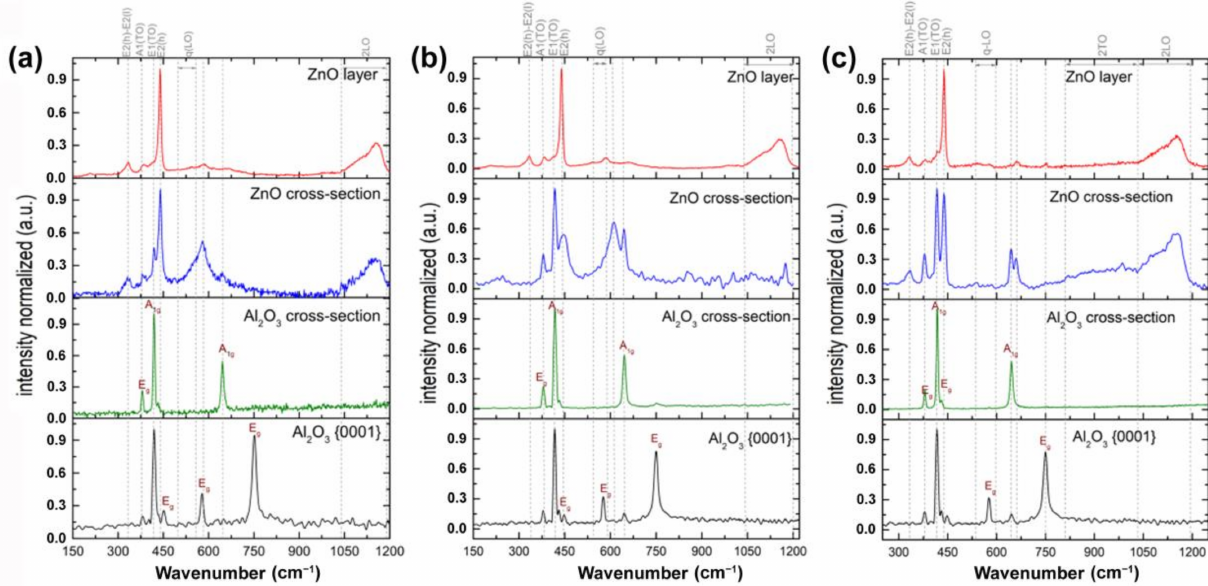
Figure 5. Raman spectra for substrate and ZnO films (on growth surface and cross-section) registered for different annealing temperatures: ( a ) 650 ◦ C, ( b ) 800 ◦ C, and ( c ) 1000 ◦ C. ZnO peaks are marked with a gray dotted line; Al 2 O 3 peaks are marked with a gray